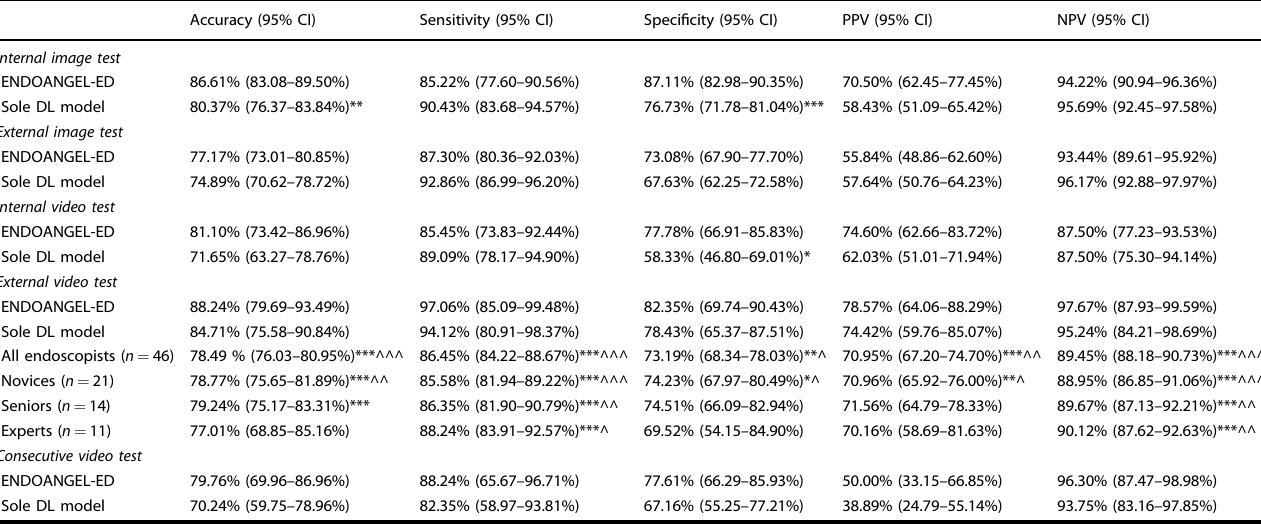
Table 1. The performance of ENDOANGEL-ED, sole DL model, and endoscopists in image and video